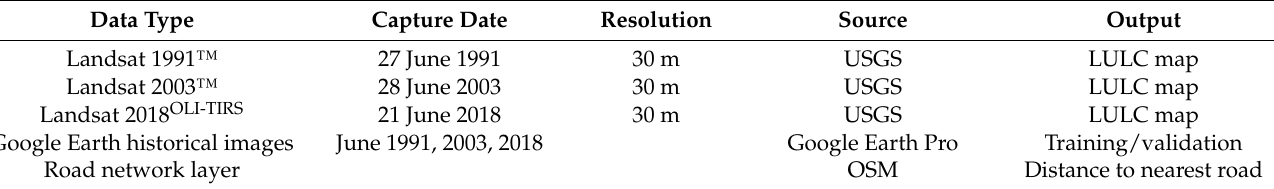
Table 1. Description of data used.